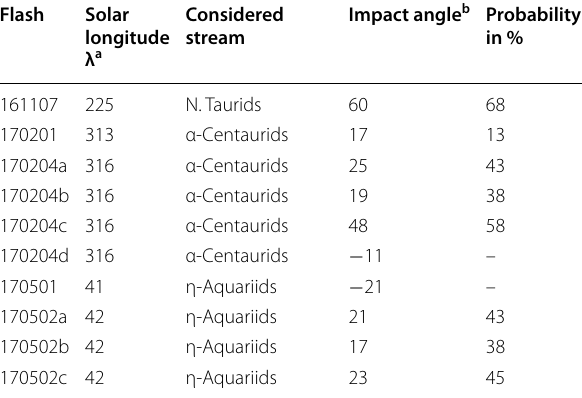
Table 6 Association with meteoroid streams